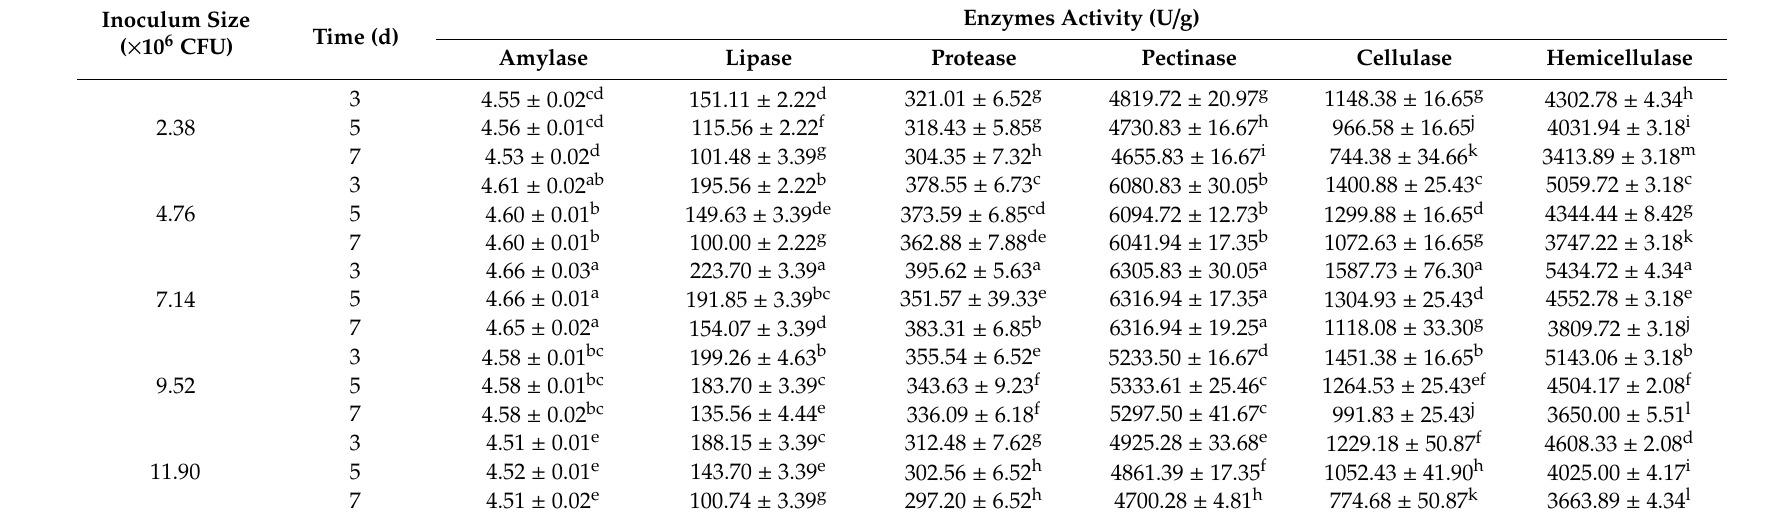
Table 5. E ff ects of inoculum size on the activities of several enzymes in fermented G. biloba